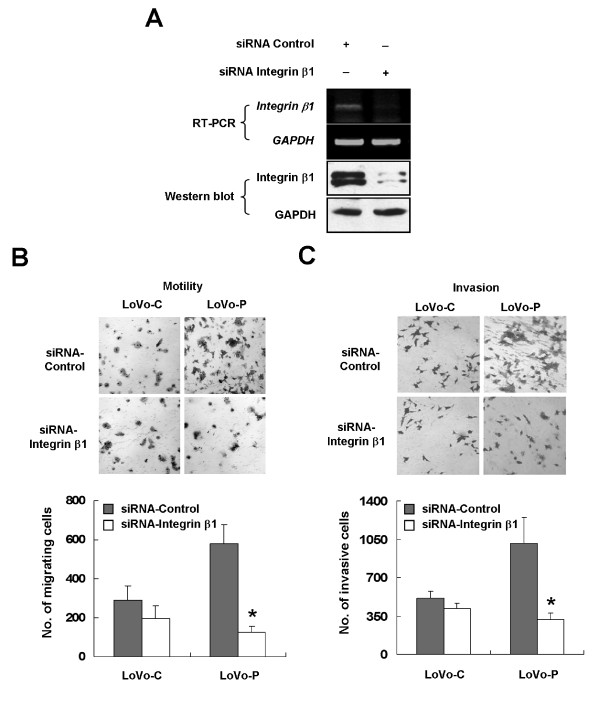
Integrin β1 mediates PRL-3-induced cell motility and invasion. (A) LoVo-P cells were treated with siRNA specific for integrin β1 or control. Seventy-two hours after transfection, cells were harvested. Equal amount of protein lysates (50 μg of protein) was analyzed for integrin β1 protein expression and RNA was extracted for RT-PCR. (B) and (C) Integrin β1 is required for PRL-3-induced cell motility and invasion. Cells were transfected with indicated siRNAs as in (A). Seventy-two hours after transfection, cells were analyzed for their motility and invasion with the use of transwell chambers. Cells were suspended in serum-free medium and loaded at a density of 2.5 × 104 to an insert of a transwell chamber, and those migrating or invading to the underside of filtera were stained and counted after 24 h (B, motility assay) or 48 h (C, invasion assay). Top panel: Representative illustrations for motility and invasion assays (original magnification, × 200). Bottom panel: Quantification of migrating and invasive cells. Values were the total number of stained cells. The experiments were repeated at least three times independently. Error bars represent standard errors of the mean value (*, P < 0.05).